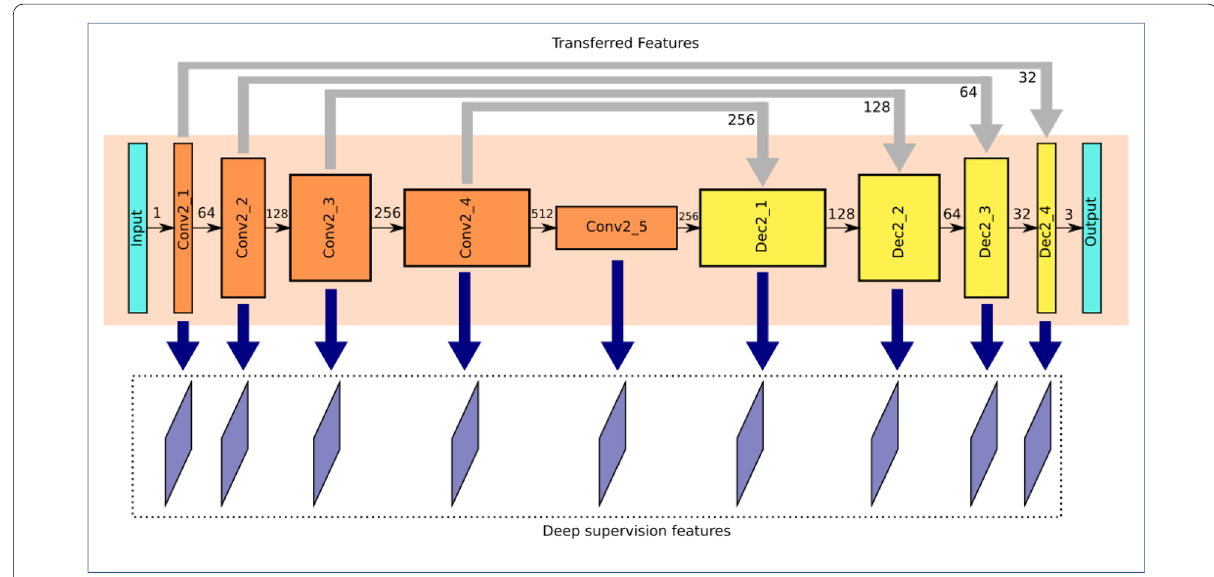
Fig. 10 The global detector is a fully convolutional neural network with deep supervision. The orange boxes represent the feature maps at each convolution layer. The yellow boxes are the feature maps at each deconvolution layer merged with the transferred features from early stages (grey arrows). The blue arrows represent the feature extraction for deep supervision at each